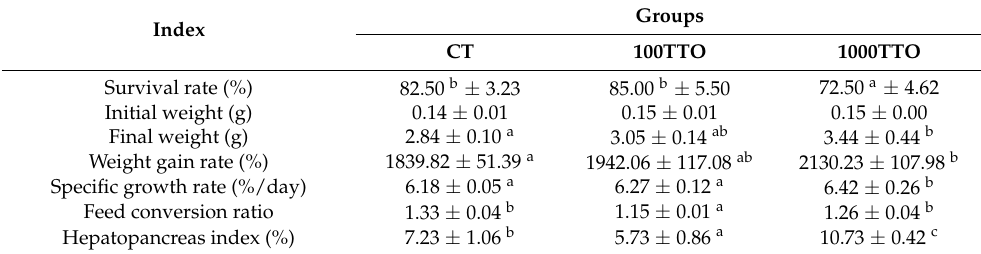
Table 2. Effects of dietary TTO levels on growth evaluation of M. rosenbergii .